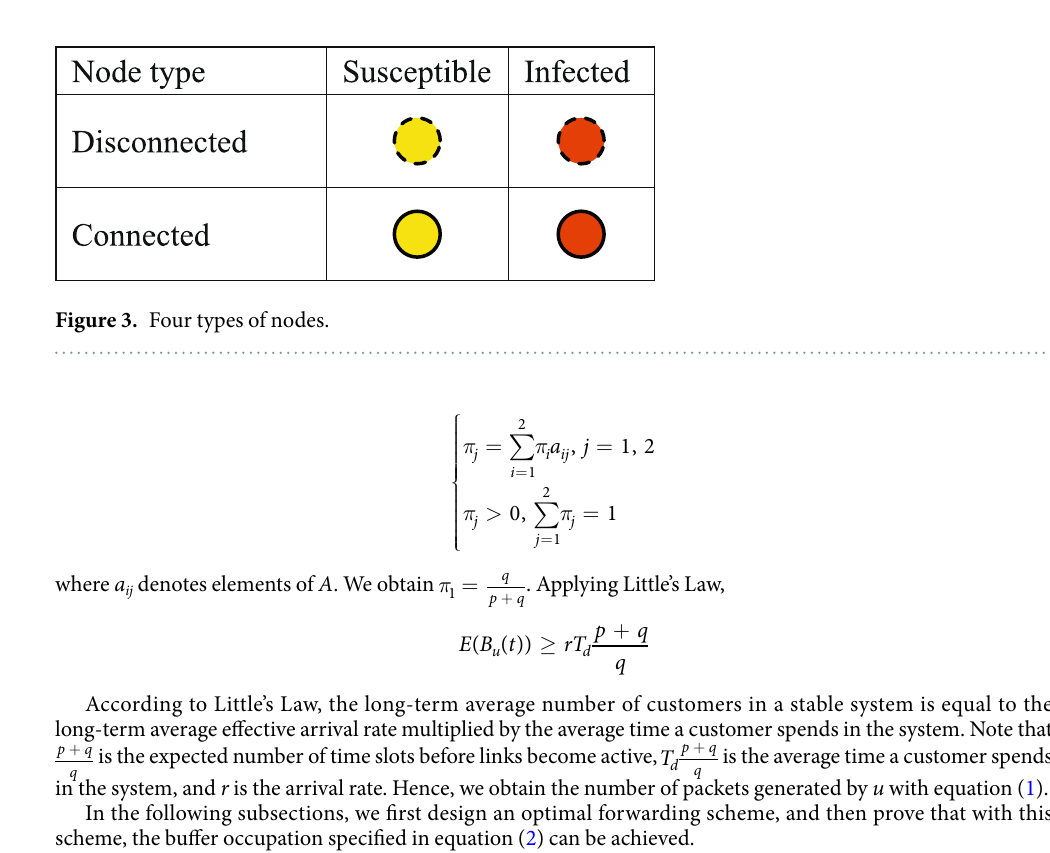
Figure 2. Three stages in the optimal forwarding scheme.